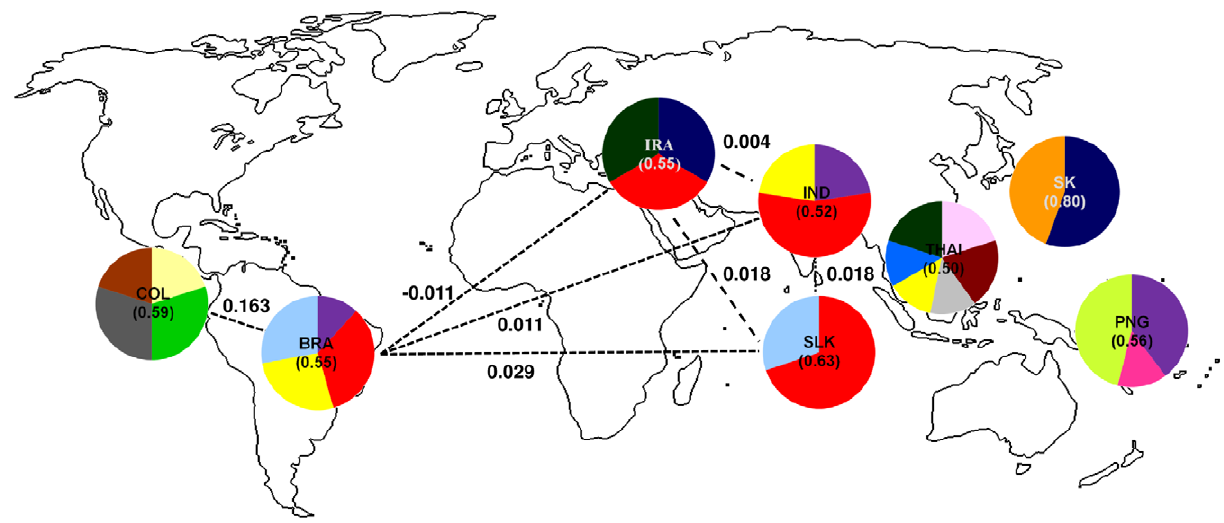
Figure 1. Frequency by country of the DBP II haplotypes that cover at least fifty percent of local parasite population. Among the 73 haplotypes defined using the 10 most prevalent nonsynonymous single nucleotide polymorphisms (nsSNPs), 17 haplotypes (each haplotype was represented by a color) were able to cover at least 50% of each country parasite population: 2 in South Korea (Hap 4 – dark blue and Hap 40 - orange) and in Sri Lanka (Hap 23 - red and Hap 44 – light blue); 3 in Iran (Hap 4, Hap 23 and Hap 59 – dark green), in India (Hap 12 - purple, Hap 23 and Hap 24 - yellow) and in PNG (Hap 12, Hap 55 – pink and Hap 64 – light green); 4 in Colombia (Hap 9 – light yellow, Hap 27 – dark gray, Hap 30 - green and Hap 37 - brown) and 4 in Brazil (Hap 12, Hap 23, Hap 24 and Hap 44); 6 in Thailand (Hap 8 – dark brown, Hap 15 – light pink, Hap 21 - blue, Hap 24, Hap 36 – light gray and Hap 59). The haplotype from Sal-1 reference strain was represented by purple (Hap 12), for haplotype sequences please see Table S2. The number in parentheses indicates the frequency of the selected haplotypes in the respective country (range from 0.52 to 0.63). Some F ST values among countries are showed and represented by dashed lines. doi:10.1371/journal.pone.0022944.g001 Table S2). The reference strain Sal-1 sequence, which has being used to develop a DBP II –based vaccine, covers only 10% of worldwide samples (Hap 12, colored in purple in Figure 1). So far, Sal-1 DBP II was detected only in three endemic areas (Brazil, India and PNG), being in very low frequency in other countries (Figure 1 and Table S2).